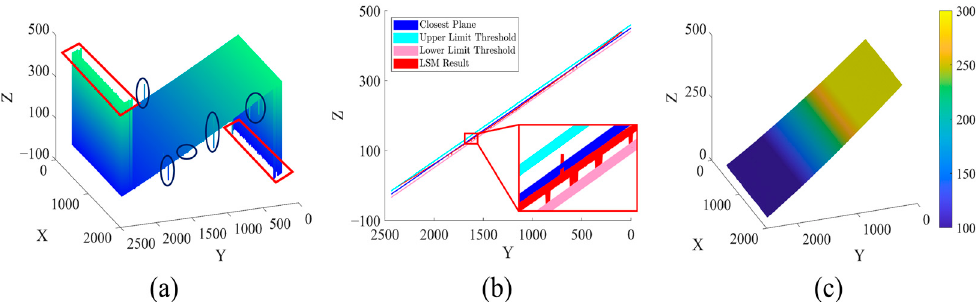
Figure 4. PUE-correction process of the proposed method: ( a ) Original unwrapped phase map obtained by Zhu’s method; ( b ) Unwrapped phase map after marking position of thick PUE; ( c ) Unwrapped phase map corrected by the proposed method.